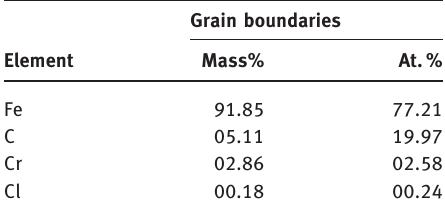
Table 9: Composition of precipitation on the sub- strate of the corrosive specimen (998.15K/ 100MPa). Grain boundaries Element Mass%